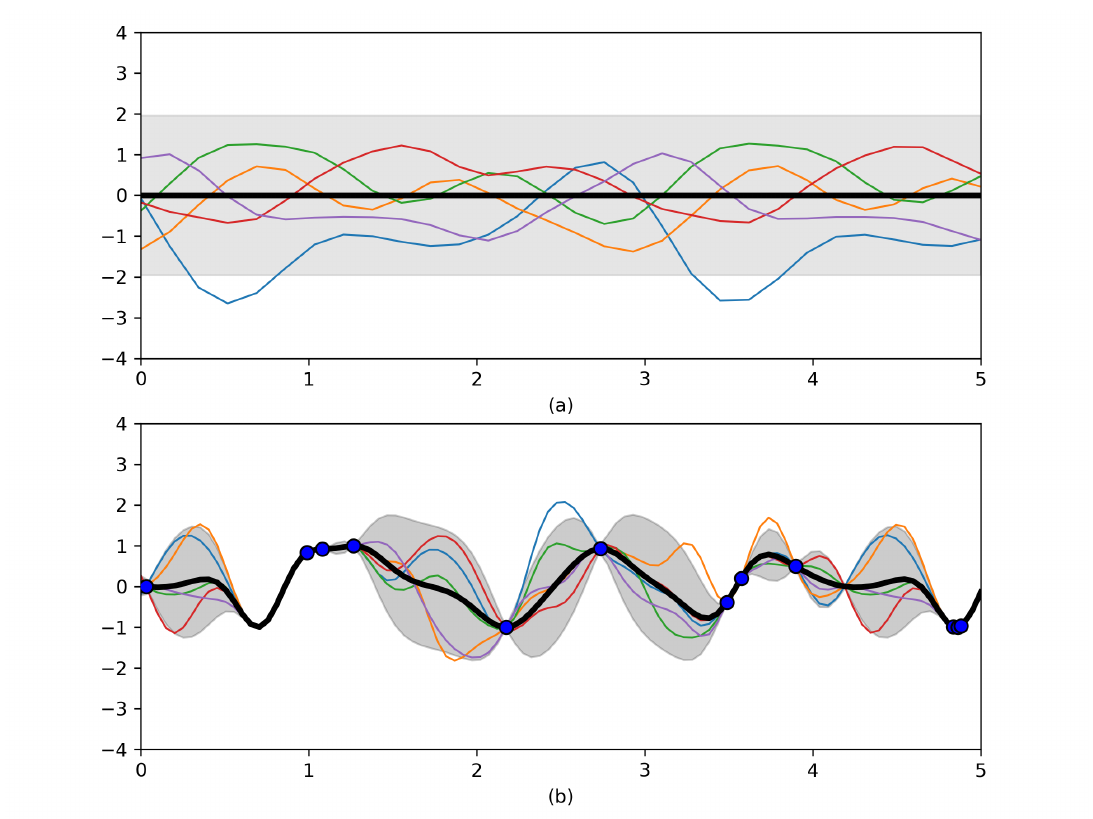
Figure 2. ( a ) Five samples from a periodic kernel prior. ( b ) Five samples from the posterior after conditioning on twelve noise-free datapoints obtained from f ( x ) = sin ( x 2 )